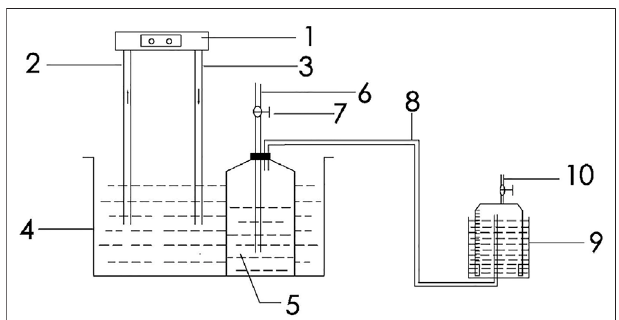
FIGURE 1 | Schematic diagram of the test setup for low-temperature anaerobic digestion system(1 Chiller;2Inletpipe; 3 Outlet pipe; 4 Water bath; 5Batchfermentationreactor;6Samplingtube;7Gasvalve;8Gaspipe;9Gas storage cabinet; 10 Exhaust